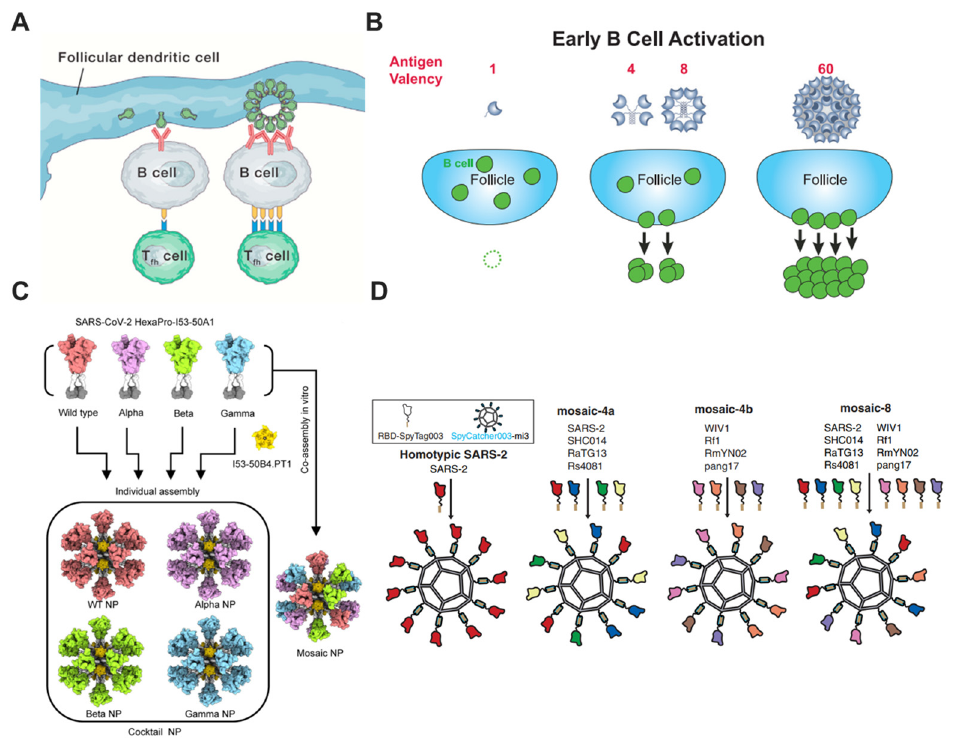
Figure 5. Nanoparticle vaccines. Nanoparticles can drain into lymph nodes, and their unique physical properties (size, shape, charge, etc.) are beneficial for antigen presentation while interacting with resident DCs. ( A ) Nanoparticles could engage stronger interactions between antigen and B cell and between B cell and the follicular helper T-cell (Tfh), resulting in stronger immunity. Reproduced with permission from Ref. [125]. Copyright 2019, Elsevier. ( B ) High valency enables robust activation and effector differentiation of B cells. Reproduced with permission from Ref. [129]. Copyright 2020, Elsevier. ( C ) Schematic diagram of SARS-COV-2 HexaPro bearing nanoparticle vaccines. Different antigens were genetically fused to I53-50A1, and an excess pentameric I53-50B.4PT1 was added at an equimolar ratio for co-assembly in vitro. Reproduced with permission from Ref. [78]. Copyright 2022, Springer Nature. ( D ) Mosaic nanoparticles were constructed by the SpyCatcher-SpyTag system. SpyCatcher is derived from a Streptococcus pyogenes surface protein, which can bind the 13-amino-acid peptide SpyTag. This system is widely applicated for protein ligation. Reproduced with permission from Ref. [35]. Copyright 2021,